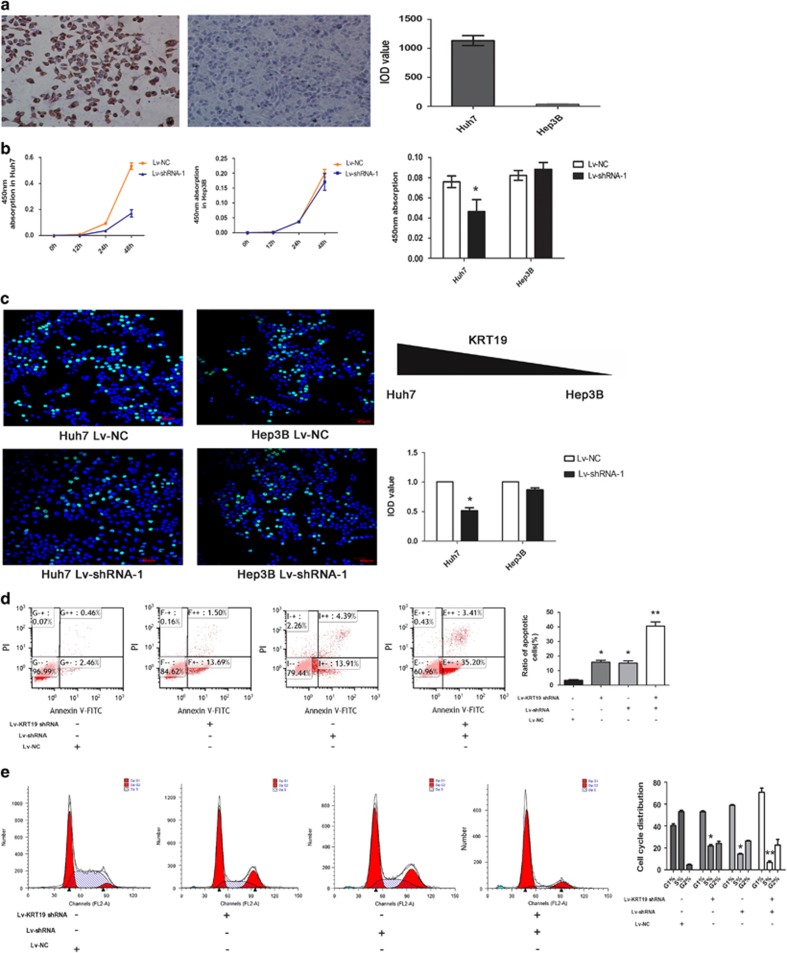
Linc00974 promote cell proliferation in KRT19-positive cells. (a) Immunohistochemical analysis was applied to detect KRT19 in HCC cell lines. We selected Huh7 (left panel) as a 100% positive stain while Hep3B (right panel) indicated an absence of KRT19 with a magnification of × 200. (b) The CCK8 assay presented showed that a decreased level of Linc00974 inhibited the growth of Huh7, and by contrast, no difference was observed in Hep3B. Absorbance at 450 nm was presented as the mean±SEM. (c) The EDU assay confirmed the functional role of Linc00974 in cell proliferation. Stable knockdown of KRT19 reduced the proliferation of Huh-7 after 24 h (P<0.01) compared with the negative control while no significant differences in proliferation were found in Hep3B with a magnification of × 200. The IOD value of cells treated with control plasmids was normalized to 100%. (d) Cells treated with lncRNA shRNA and KRT19 shRNA followed. Forty-eight hours after treatment, cells were stained and analyzed by flow cytometry. LR, early apoptotic cells; UR, terminal apoptotic cells. (e) At 48 h after treatment, cell cycle was analyzed by flow cytometry. The bar chart represents the percentage of cells in G1–G0, S, or G2–M phase. All experiments were performed in triplicate and presented as the mean±S.E.M. (*P<0.05, **P<0.01)